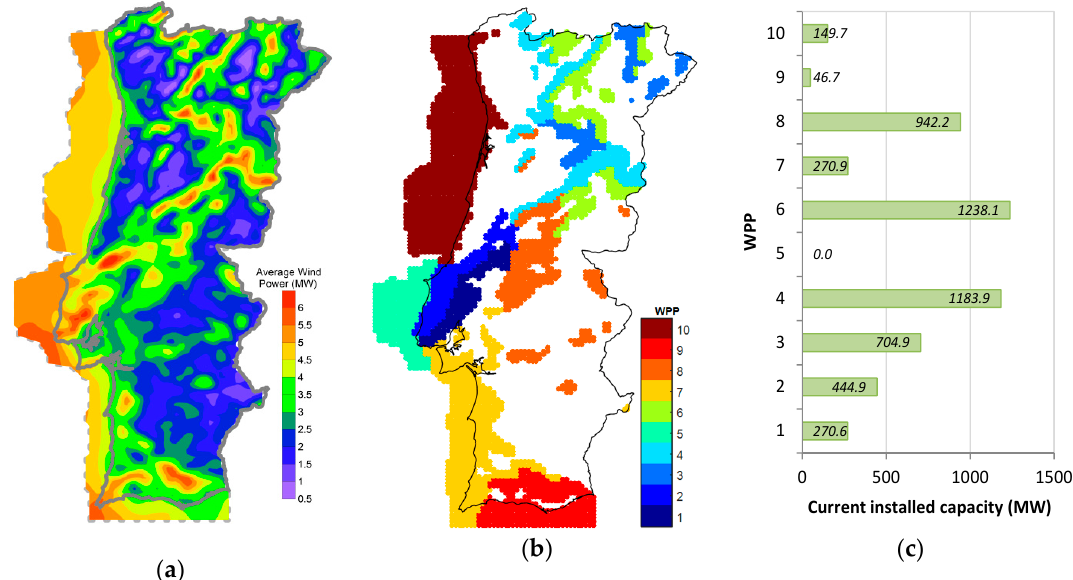
Figure 4. ( a ) Average wind power production, ( b ) spatial distribution of the wind power profiles (WPPs) (only spatial points with an average wind speed above 5.5 m/s are presented and used, and ( c ) current wind power capacity in each WPP.